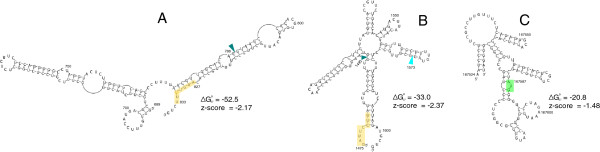
Predicted RNA structures containing splice sites and a start codon. (A) Structure model for RNAz-predicted structural region locus 1 (in LMP-2B gene). The splice donor site is indicated with a dark blue colored wedge and a putative intronic splicing enhancer is colored yellow. (B) Structure model for locus 2 (in the LMP-2B gene). The splicing acceptor site is indicated with the light blue wedge and the yellow box now indicates a putative exonic splicing enhancer. (C) Structure model for locus 263. The start codon for latent membrane protein 2A (LMP-2A) is indicated by the green box.